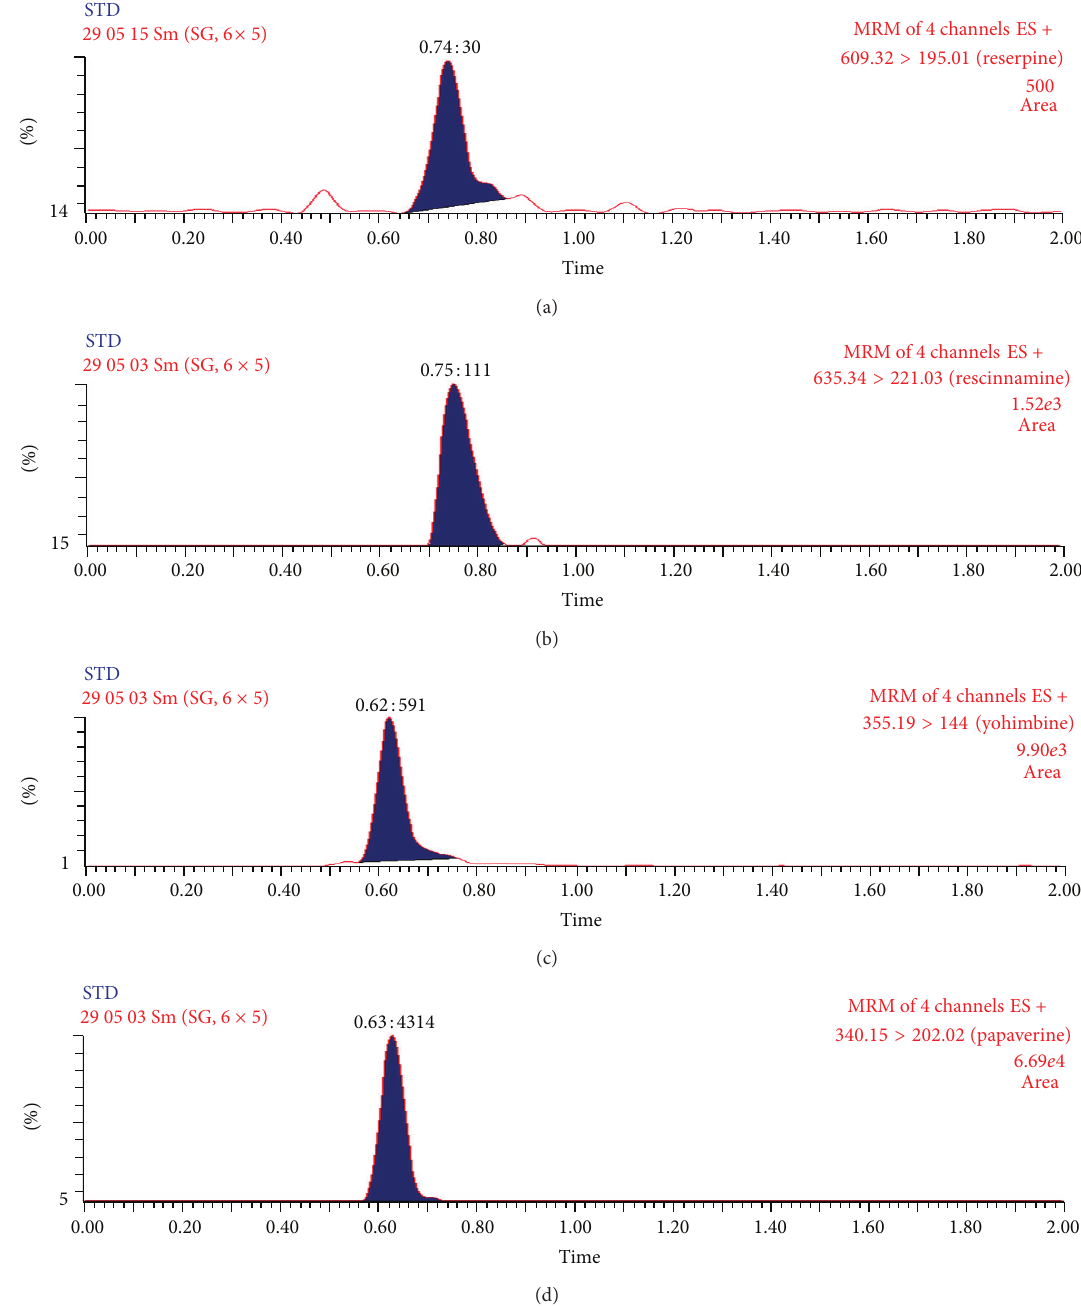
precisions were ≤ 8.3, whereas the intra- and interday accu- racies were in the range of 89.8–111.1%. For rescinnamine, the intra- and interday precisions were ≤ 9.6, whereas the intra- and interday accuracies were in the range of